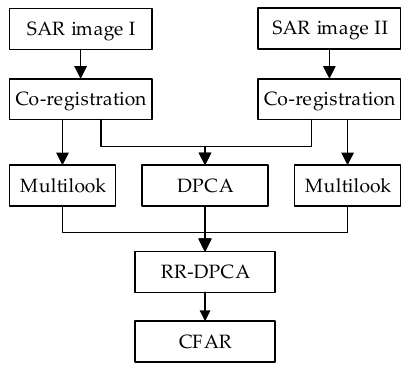
Figure 4. Flowchart of proposed method based on RR-DPCA.